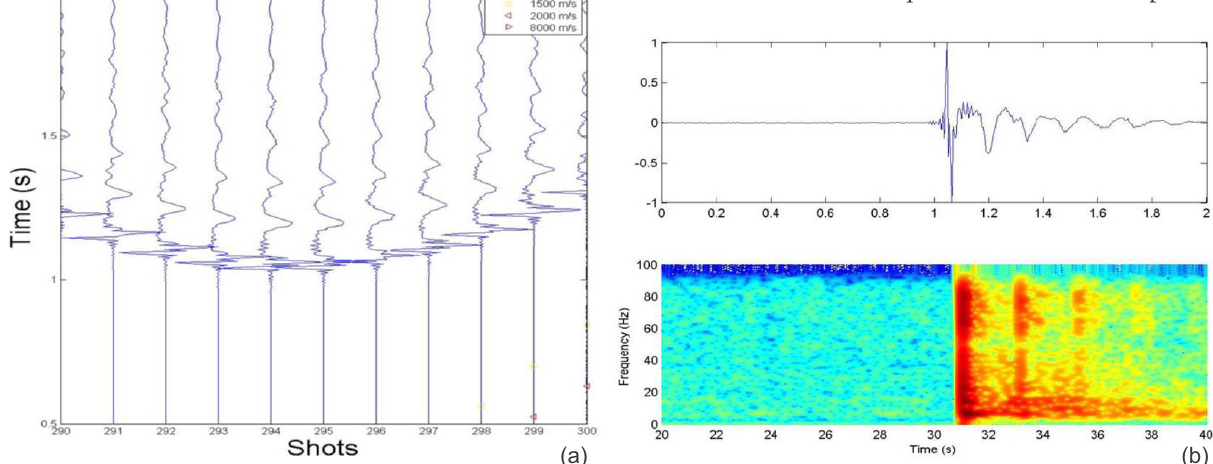
Figure 3. (a). Set of ten shots recorded by the OBS ‘SPAI03’ on June 29, 2014. (b) Waveform detail and spectrogram for the registration of the shot done while the vessel was located on the exact vertical of OBS